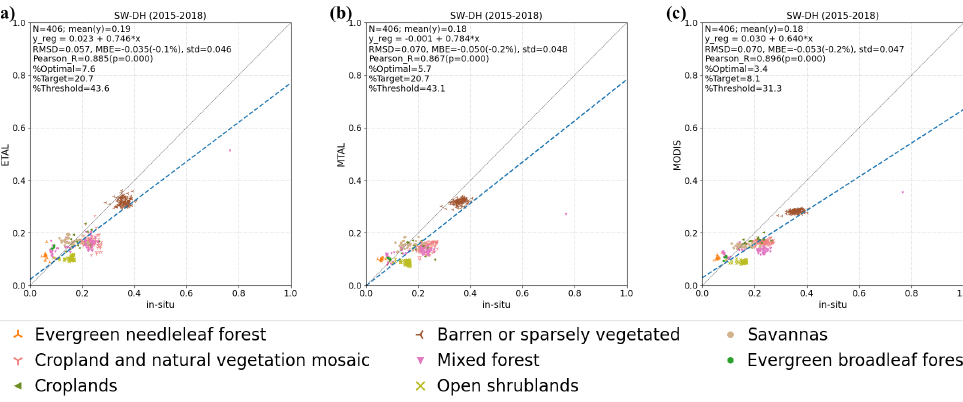
Figure 7. Accuracy assessment of ( a ) ETAL, ( b ) MTAL-R/NRT and ( c ) MODIS surface albedo satellite products versus ground measurements coming from GBOV, AMMA and BSRN stations during the 1 January 2015–31 December 2018 period. Only those dates that provided concomitant data for all three satellites products and ground measurements were considered. The continuous black line corresponds to the 1:1 line. The blue dashed line corresponds to the regression